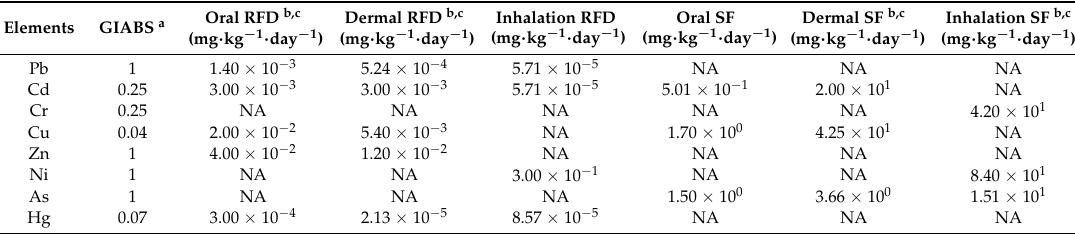
Table 3. Summary of reference dose (RfD) and cancer slope factor (SF) of metals and the metalloid As through oral, dermal and inhalation